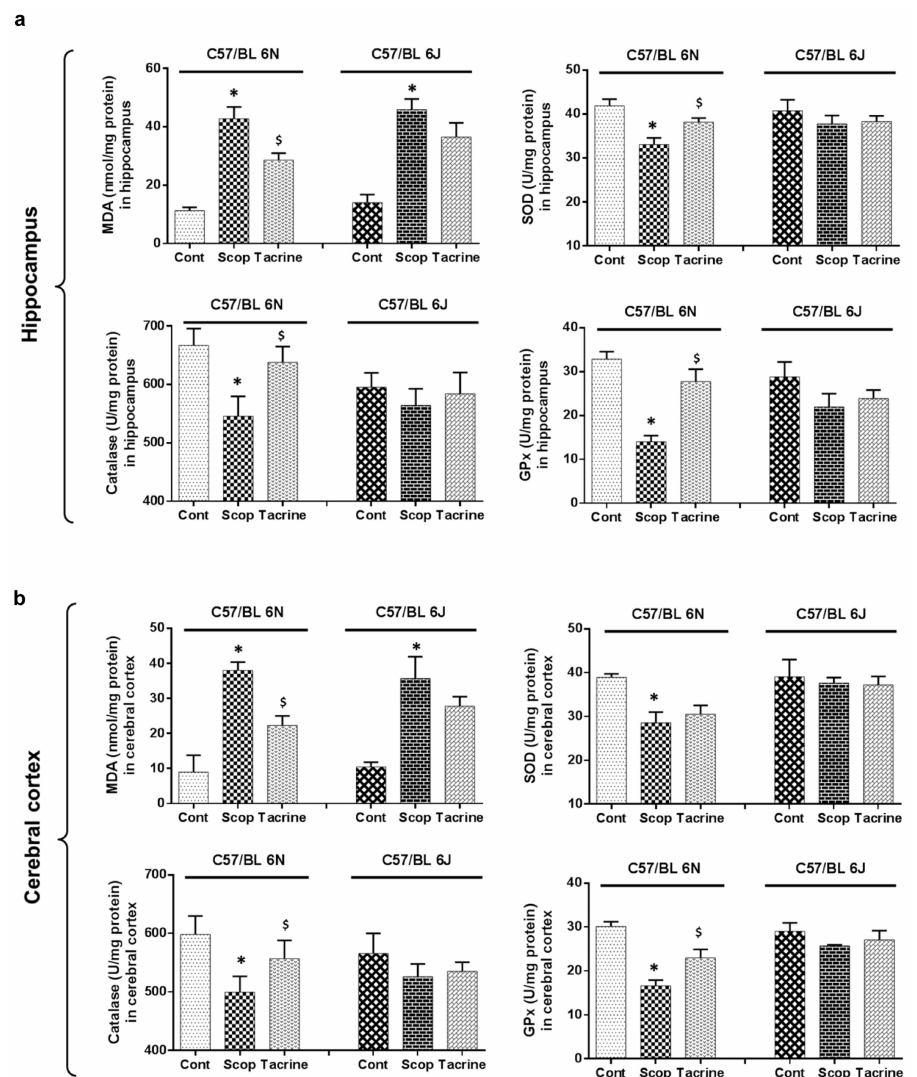
Figure 7. Endogenous level of oxidative stress biomarkers in brain tissue of